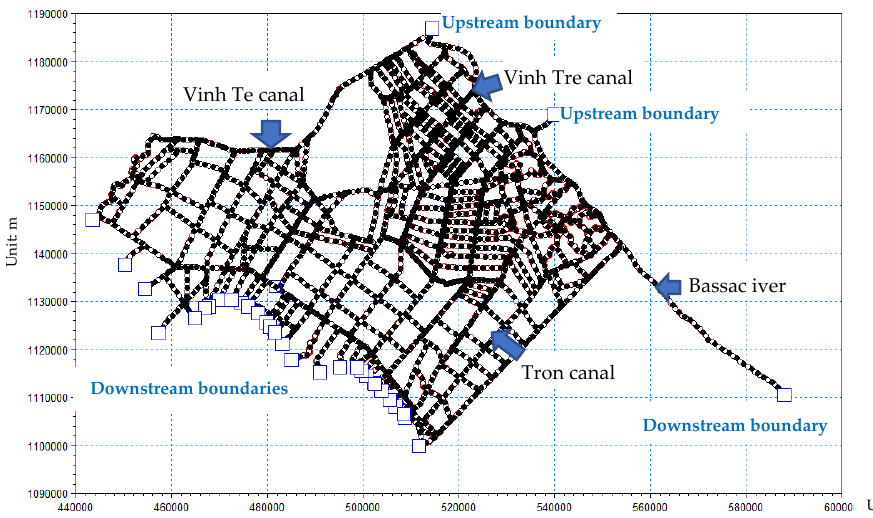
Figure 3. The river and canal network in the LXQ. Blue squares denote the HD (discharge in the upstream and water levels in the downstream) and EcoLab (BOD 5 , DO and temperature) bounda- ries.